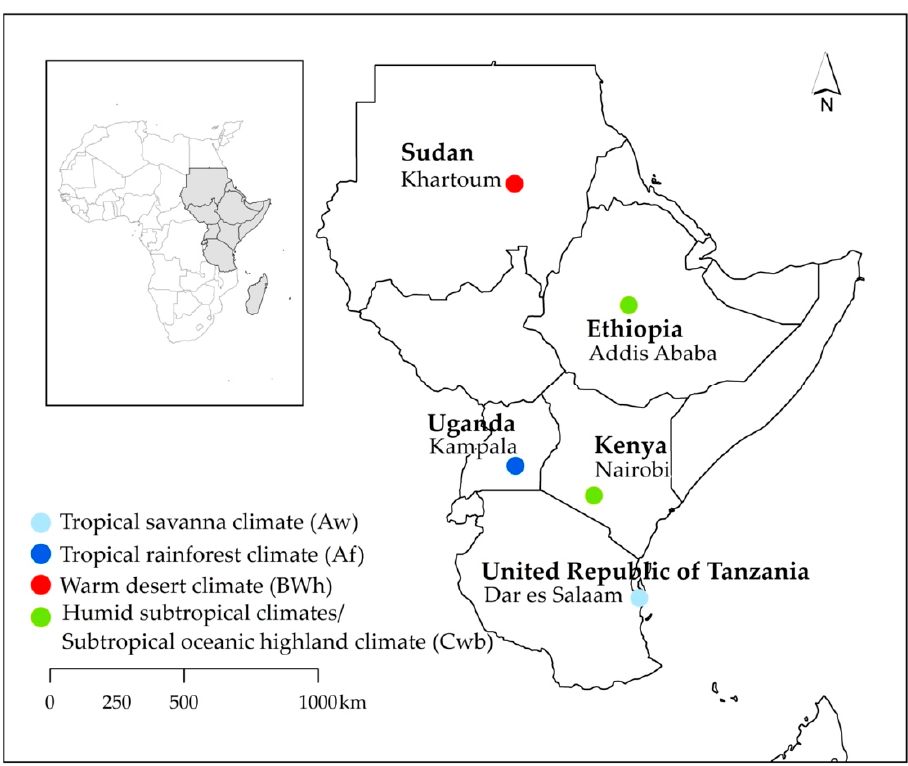
Figure 1. The location of study area and Africa.